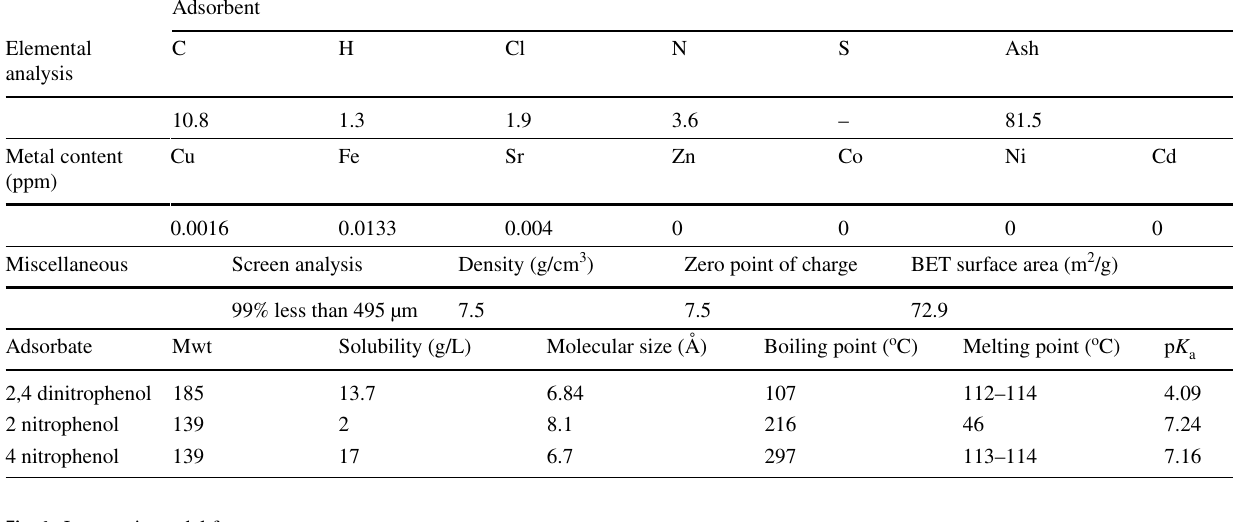
Fig. 1 Langmuir model for adsorption of phenols on char ash